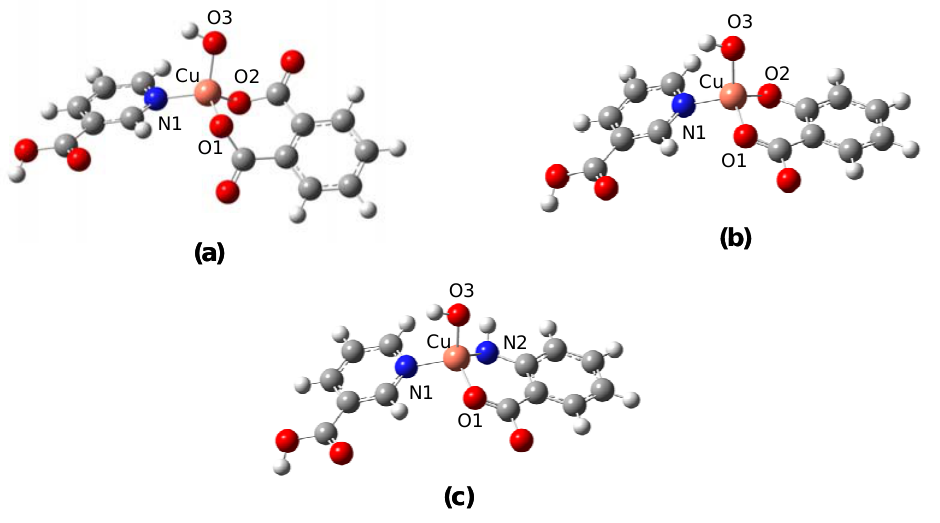
Figure 2. Molecular structures of copper coordination complexes 1 (a), 2 (b), and 3 (c).